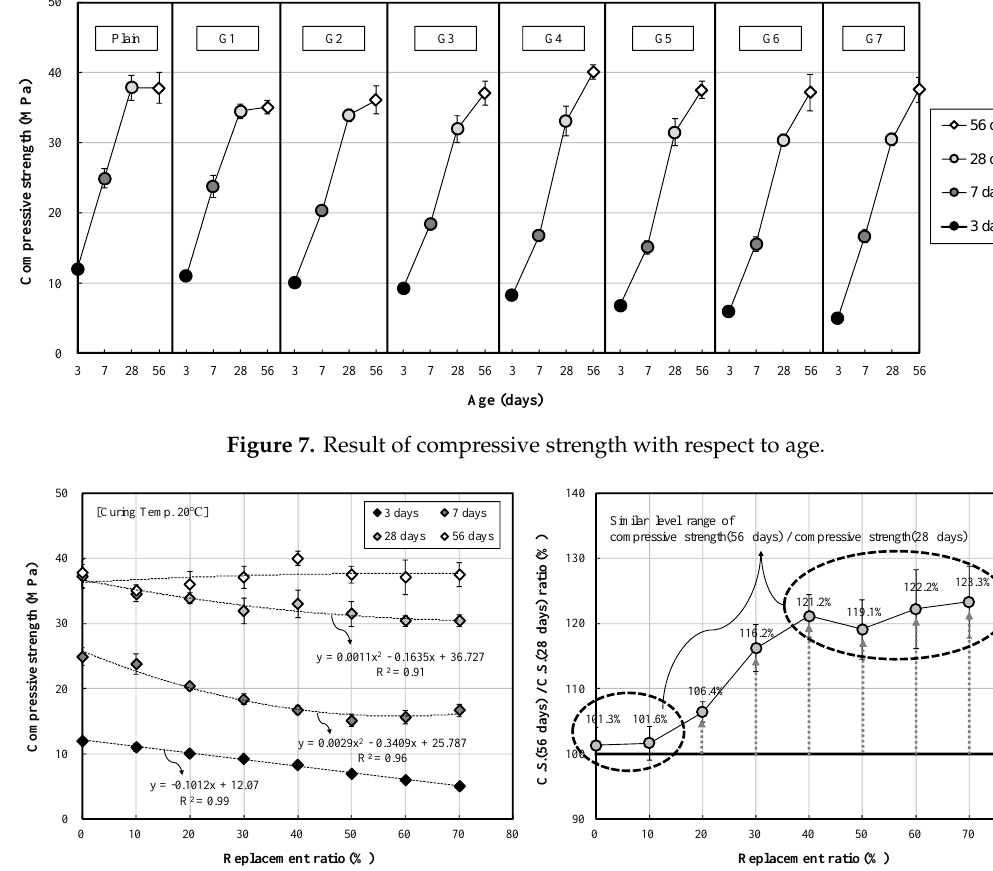
Figure 6. Result of unit water content with respect to replacement ratio.